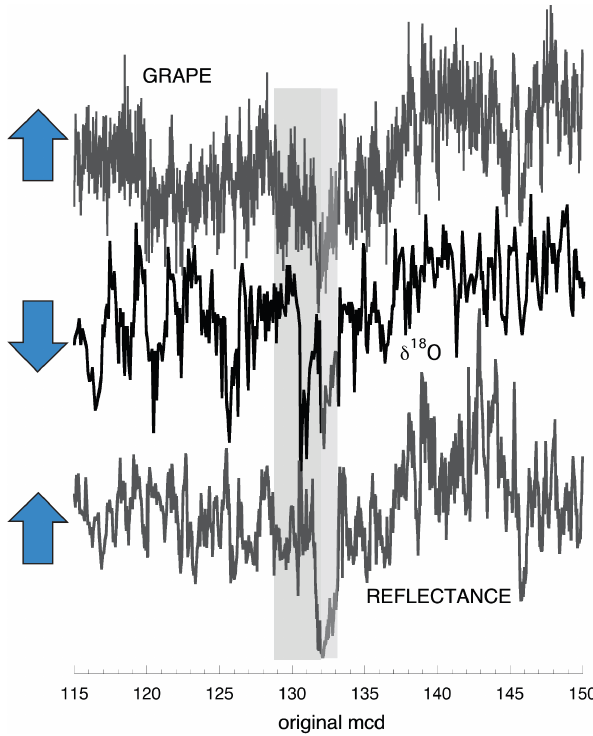
Figure 7. Comparison of δ 18 O series of Shackleton et al. (1995b) on original composite depth (Shipboard Scientific Party, 1992) in comparison to reflectance and GRAPE data (original shipboard composite). Note the anomalous interval encompassing the M2 glacial event, indicated by gray shading where the isotopically enriched values depart from their correlation to reflectance and GRAPE